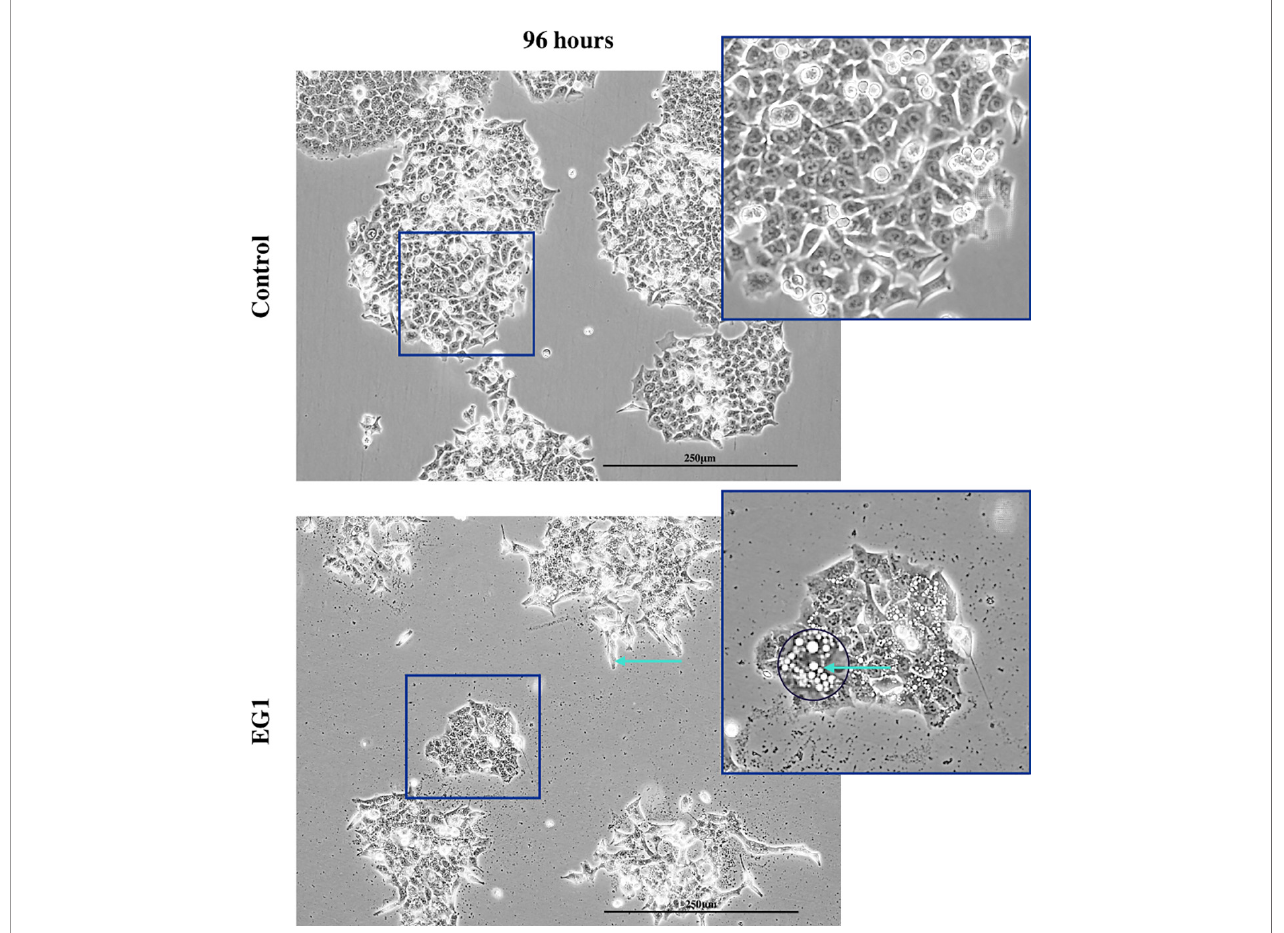
FIGURE 7 | Light microscopy imaging of the control and EG1 treated cultures. Light microscopy image of the control and EG1 treated cultures after 96 hours. The EG1 treated cultures had visibly less growth with some having an elongated phenotype and membrane blebbing (green arrow), an apoptotic feature of epithelial